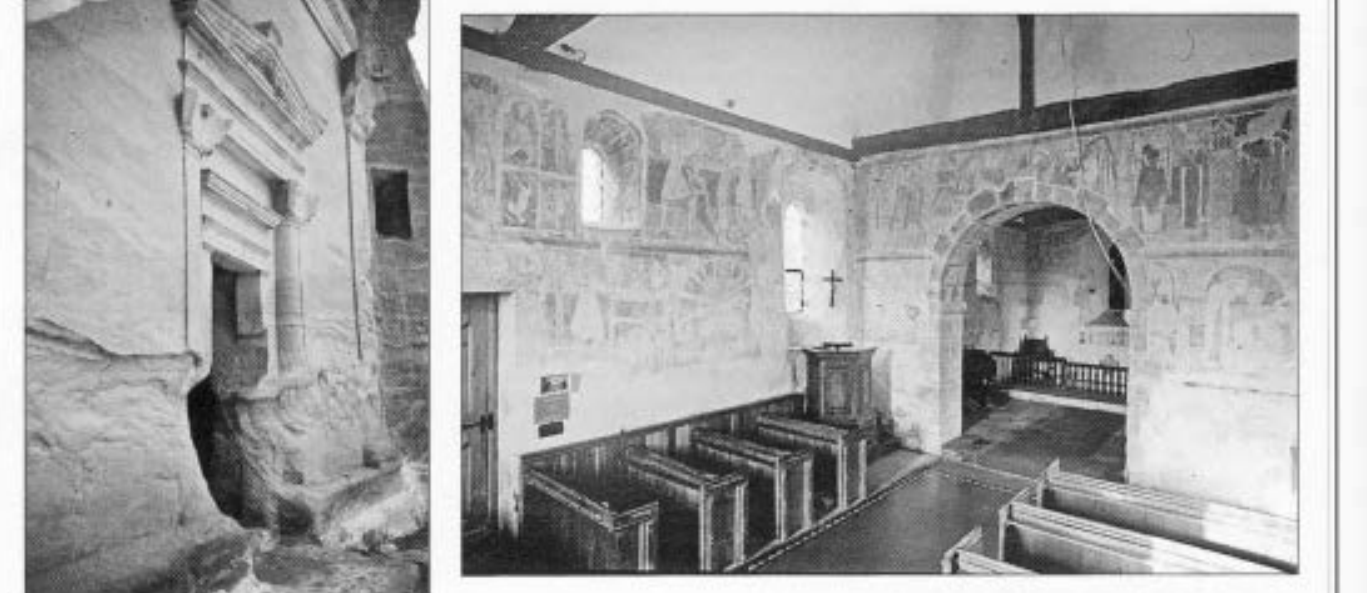
Figure 2 The interior of the nave of Hardham Church, West Sussex, 1997. The twelfth­ century wall paintings at Hardham form the most complete cycle of Romanesque wall Figure 1 Rock-cut far;;ade of a tomb at Petra, Jordan, showing severe salt damage paintings surviving in England. Sadly, they are in extremely poor condition, primarily along the base. because of the effects of salt